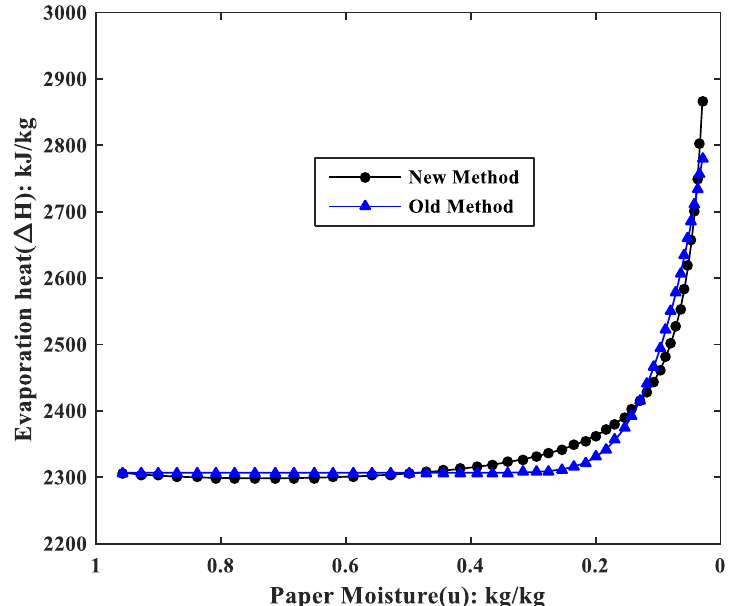
Figure 7. Comparison of results between the new and old methods in industrial production.